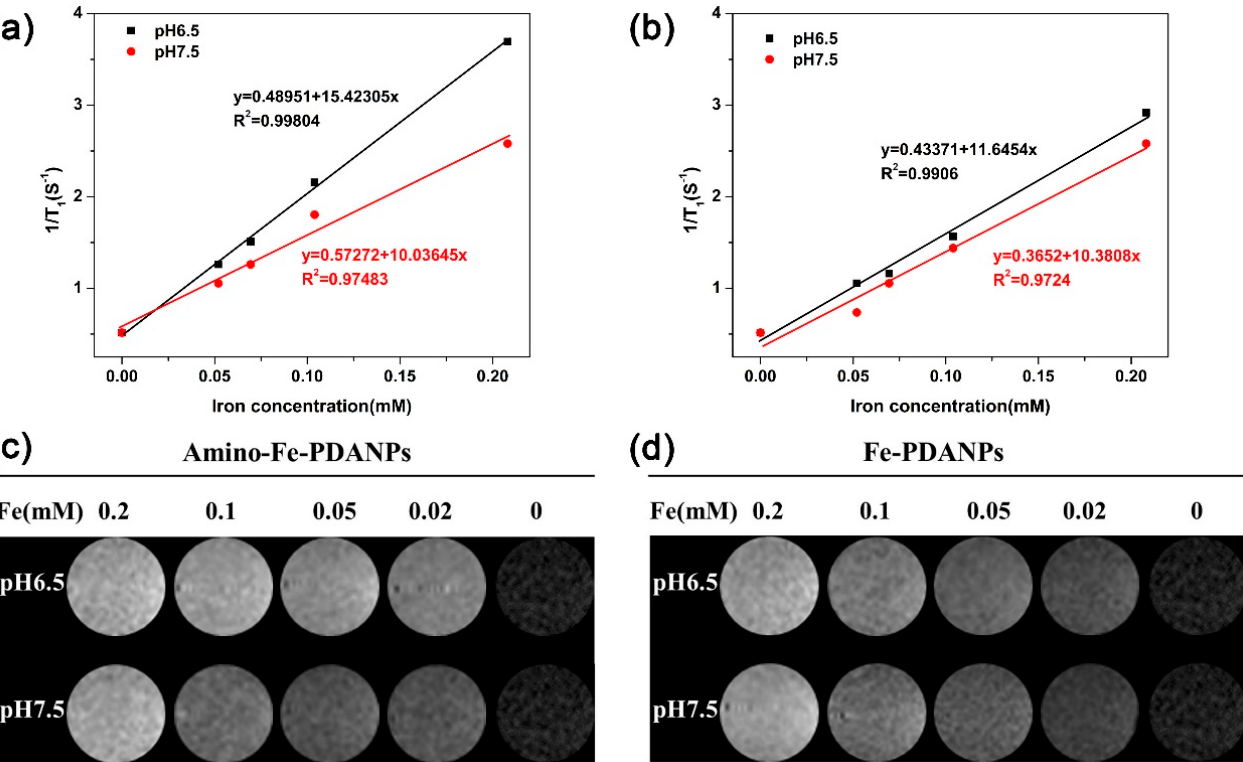
Figure 5. The plots of 1/T 1 as a function of the molar concentration of Fe 3+ in the solution under pH 6.5 and pH 7.5 for ( a ) the amino-Fe-PDANPs and ( b ) Fe-PDANPs; T 1 -weighted MRI phantom results from ( c ) amino-Fe-PDANP S and ( d ) Fe-PDANP S as a function of the molar concentration of Fe 3+ in the solution under different pH values. Water is the control group.